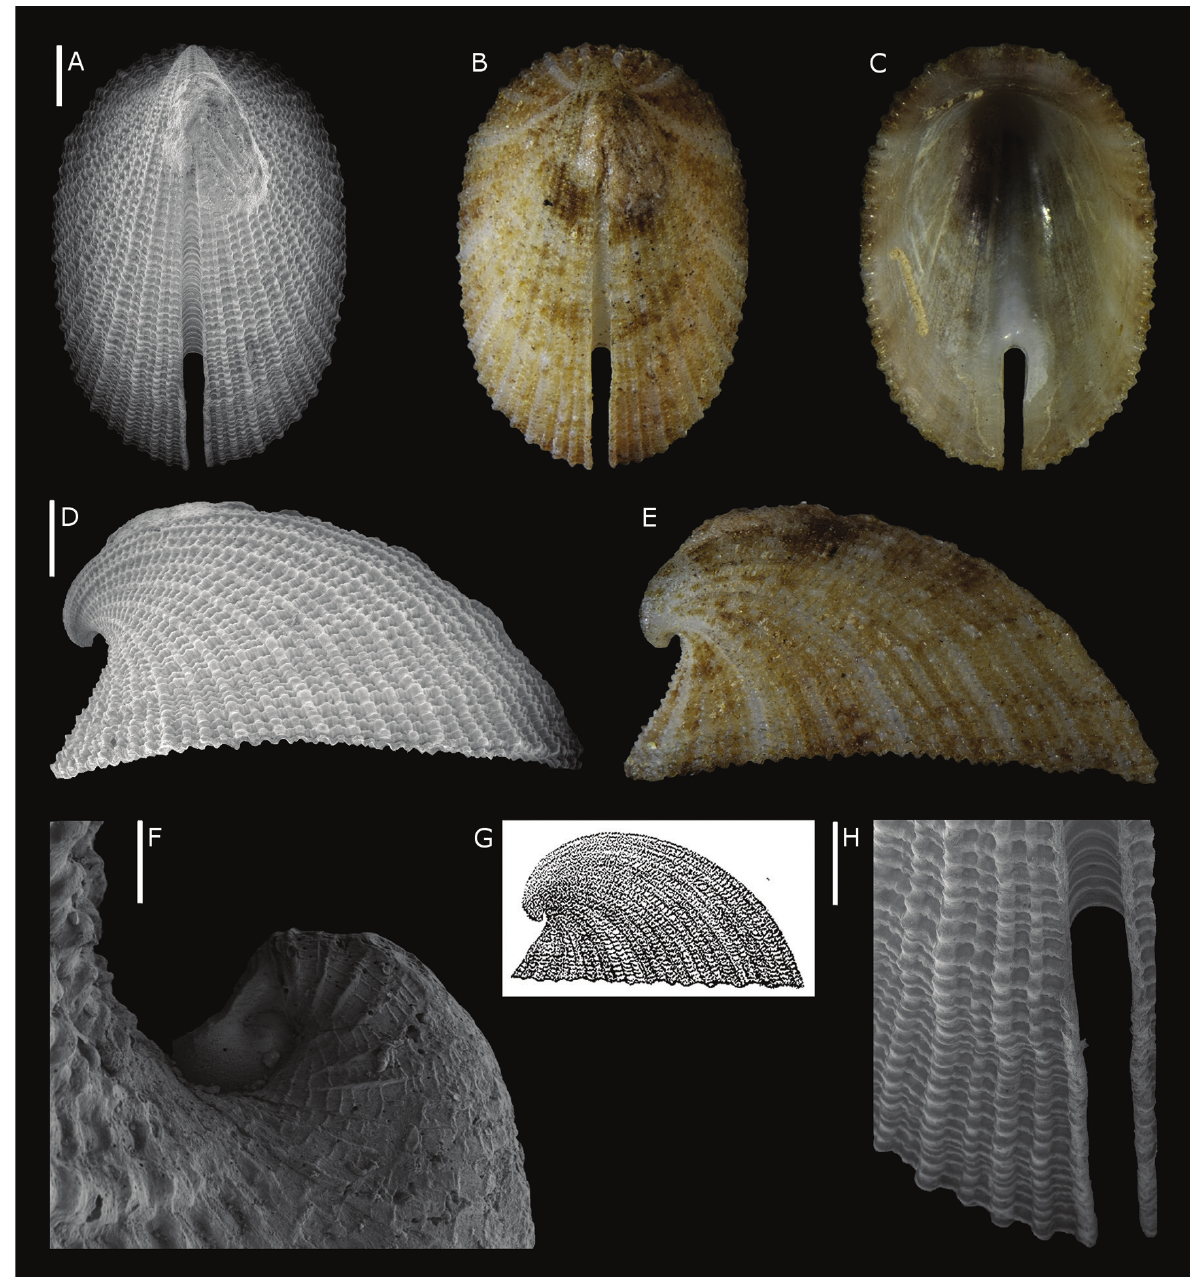
Figure 1. Emarginula harmilensis Sturany, 1903, Station 143 (Harmil Island, Dahlak Archipelago, Eritrea, Red Sea). A–F, H . Holo- type, NHMW 84290: top ( A–B ), aperture ( C ), left side ( D–E ), protoconch ( F ), microsculpture ( H ). G . Original figure by Sturany (1903). Scale bars: A–E : 1 mm, F : 0.1 mm, H : 0.5